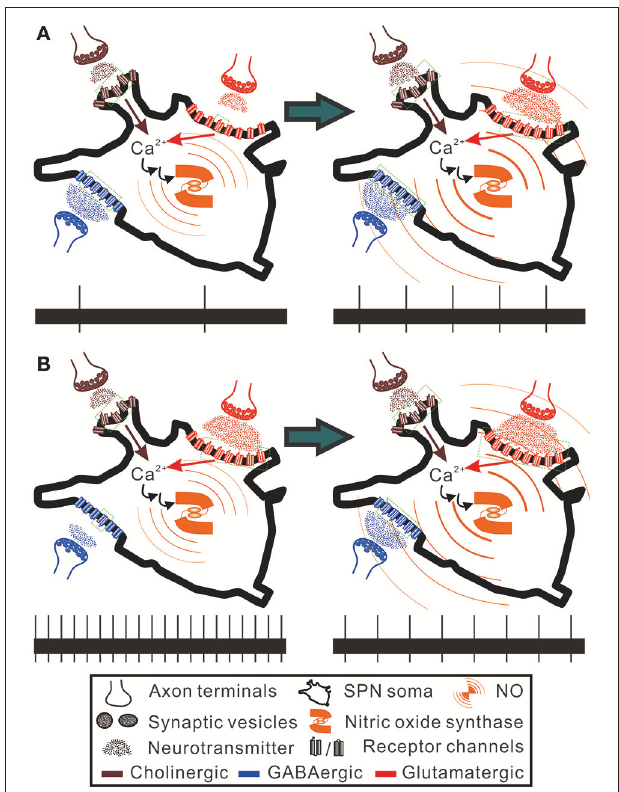
FIGURE 10 | Hypothetical scenarios to explain the paradoxical spiking responses elicited by NO enhancement in SPNs of low and high spontaneous activities. Here, the SPNs of high and low activity levels are presumed to express nitric oxide synthase and are bombarded by GABAergic and glutamatergic synaptic inputs to different extents, as hypothesized in Figure 9 . Also, NO is presumed to enhance cholinergic, GABAergic and glutamatergic neurotransmission to SPNs (see section Discussion for references). Brown and red arrows indicate Ca 2 + influxes from nicotinic cholinergic receptors and ionotropic glutamate receptors, which participate in activating nitric oxide synthase. Green dotted squares enclose the receptor channels in open states. The bottom trace in each panel shows a 20-s epoch of spiking activities under control conditions (the left panels) and during NO enhancement (the right panels). (A) NO enhancement increases spiking activities from 0.1 to 0.25Hz. (B) NO enhancement decreases spiking activities from 1 to 0.4Hz. By counting the numbers of the receptor channels in open and closed states, NO enhancement causes only a fractional change of GABAergic neurotransmission in (A) and a fractional change of glutamatergic neurotransmission in (B) . In contrast, NO enhancement causes a five-fold increase of glutamatergic neurotransmission in (A) and a three-fold increase of GABAergic neurotransmission in (B) . Thus, alteration of the spiking activities by NO predominantly follows a recruitment of closed receptor channels or silent synapses. The hypothetical scenarios explain an activity-dependent heterogeneity in NO modulation of sympathetic firing